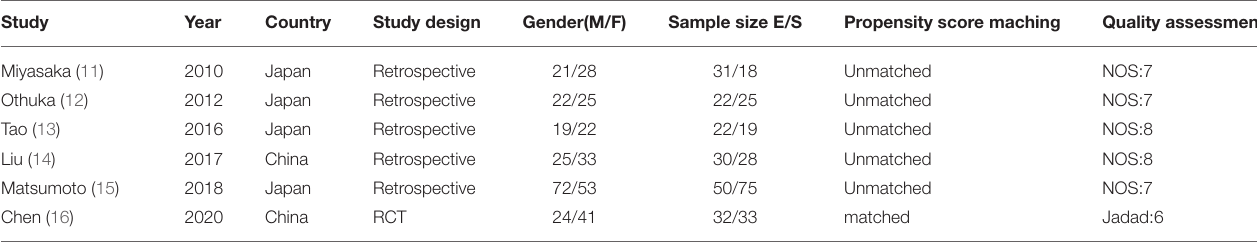
TABLE 1 | Characteristics of the included clinical